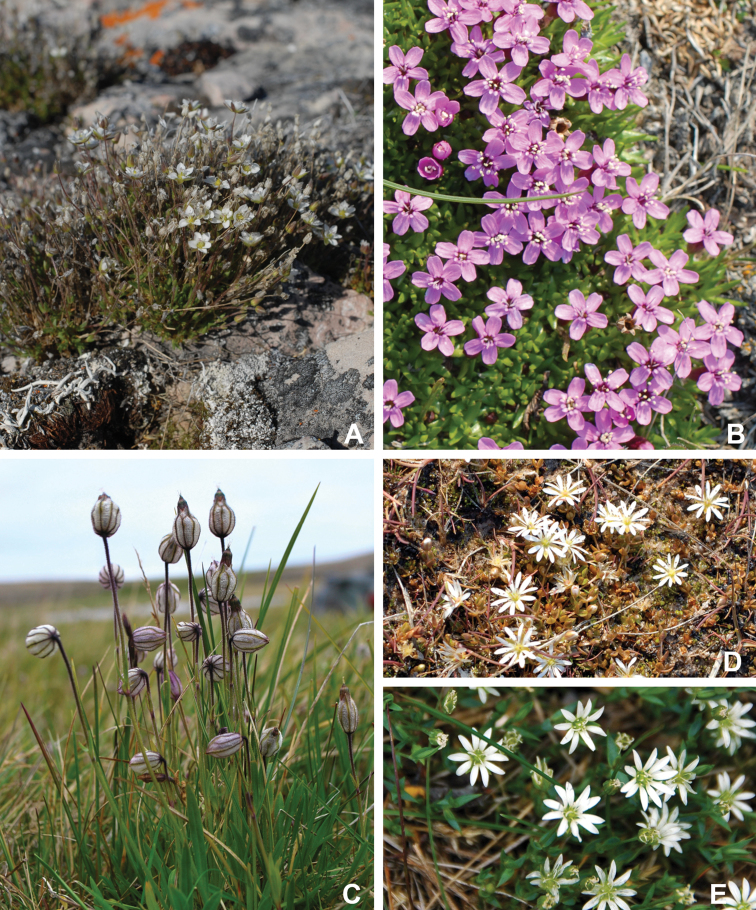
ASabulina
rubella habit, Gillespie et al. 7591BSilene
acaulis habit, Johansen Bay, NU, 20 July 2008 CSilene
uralensis
subsp.
arctica habit DStellaria
humifusa habit, Gillespie et al. 8200EStellaria
longipes habit, Johansen Bay, NU, 18 July 2008. Photos A, B, D, E by R.D. Bull and C by B.A. Bennett.